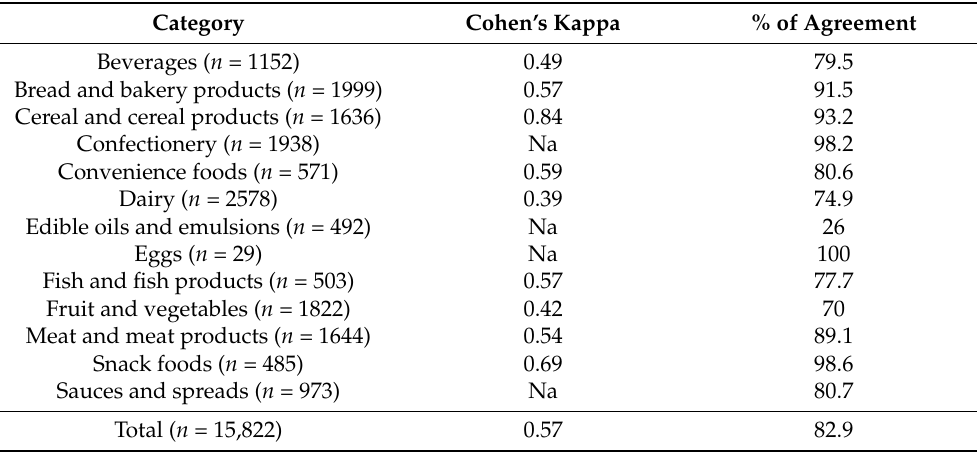
Table 1. Agreement between the Nutri-Score and the nationally adapted WHOE profile for main categories using Cohen’s kappa and percentage of